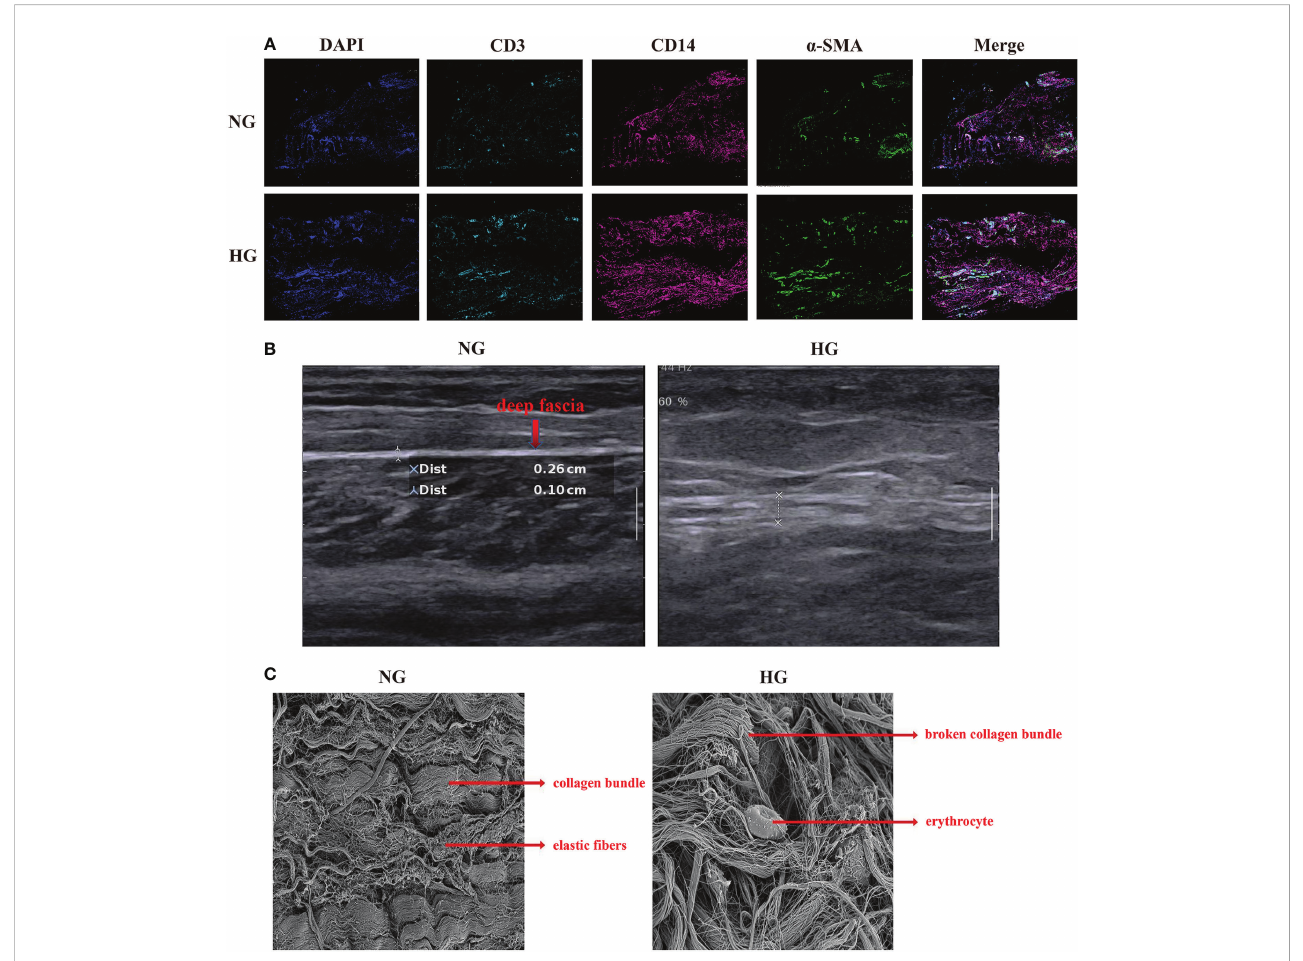
FIGURE 2 Multiplex staining and multispectral imaging, ultrasound and Scanning Electron Microscope for deep fascia in two groups. (A) Multiplex staining and multispectral imaging showing fi broblasts and immune cell in fi ltration, including T cells and myeloid cells in HG compared with NG. *green ( a -SMA): fi broblast; pink (CD14): myeloid cells; blue (CD3): T cell. (B) ultrasound in patients with in HG (right side) compared with the NG (left side) in ultrasound. (C) Scanning Electron Microscope in HG and NG. Left: parallel arrangement of collagen fi ber bundles in NG; right: chaotic overall arrangement of collagen fi ber bundles in HG. HG, high stress group; NG, normal stress